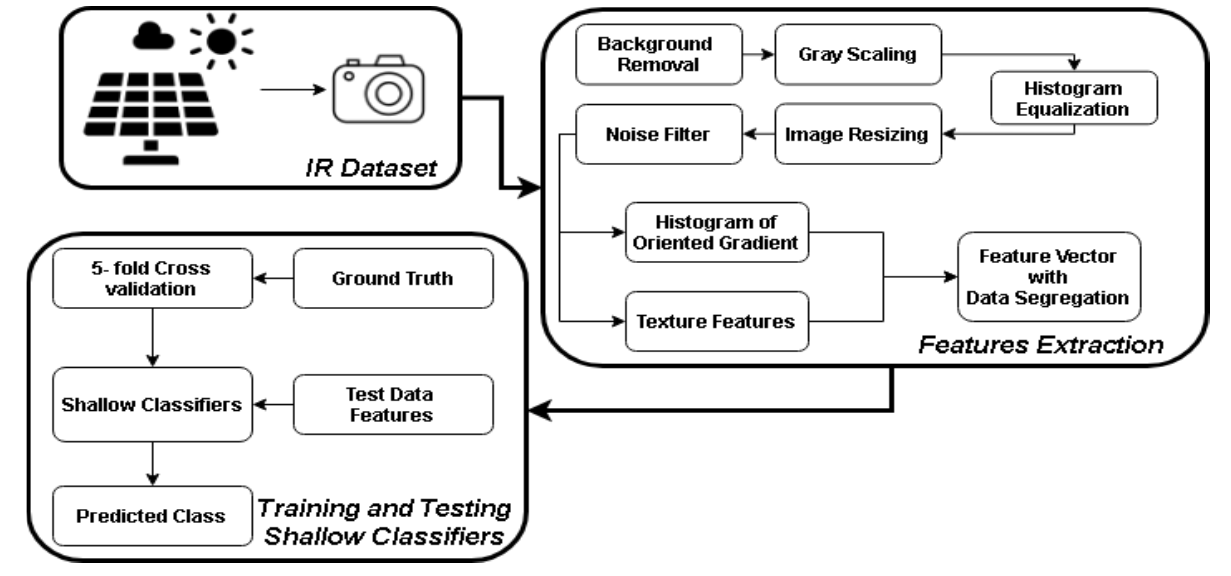
Figure 3. A manual feature extraction approach.